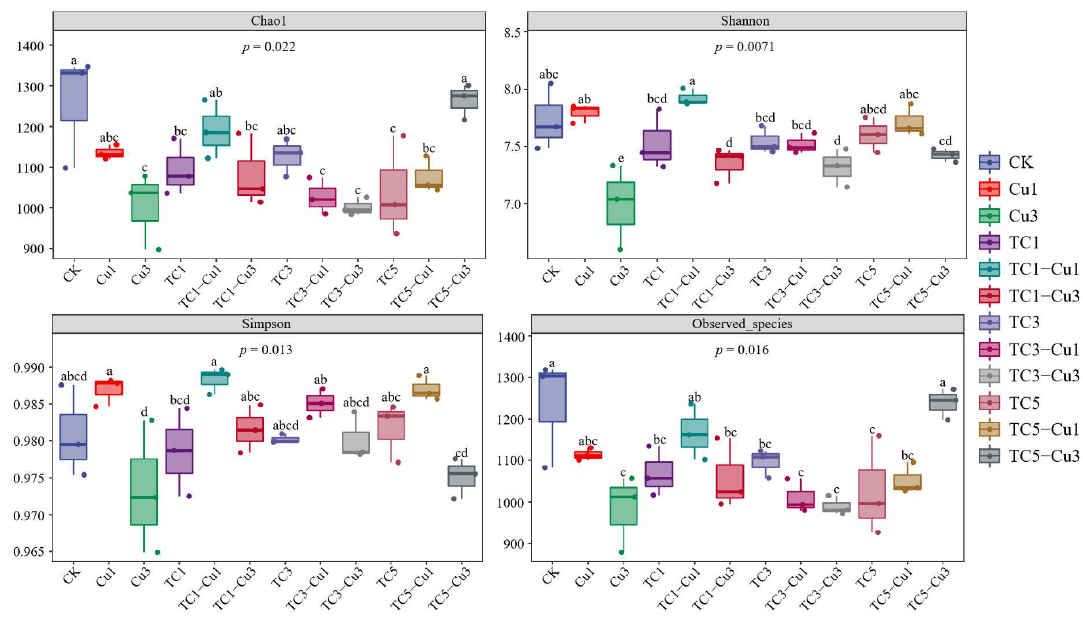
Figure 3. Box-line plot of alpha diversity of soil bacterial communities under TC and Cu contamina- tion. Different letters indicate significant difference between different treatments ( p <